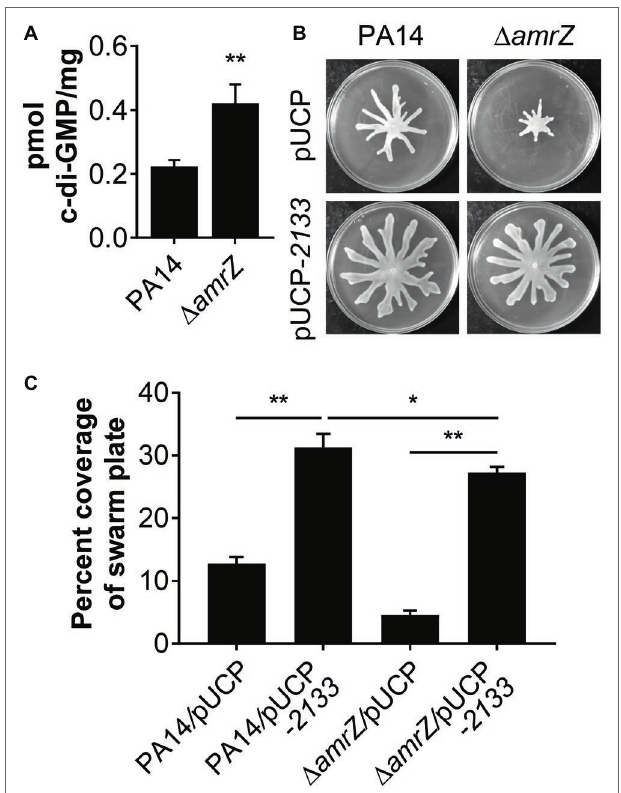
FIGURE 3 | c-di-GMP contributes to the swarming defects of the amrZ mutant. (A) Measurements of c-di-GMP by LC-MS/MS for the indicated strains grown on swarm plates. Data are expressed as pmol of c-di-GMP/mg of dry weight of the cell pellets from which the nucleotides were extracted. (B) Representative swarming images of the WT or amrZ mutant carrying either the empty vector or pUCP- 2133 for overproducing the PA2133 phosphodiesterase as indicated. (C) Percent coverage of swarm plates for the strains shown in (B) . Statistical analysis is based on three replicates and significance was determined with Student’s t -test (* p < 0.05; ** p <